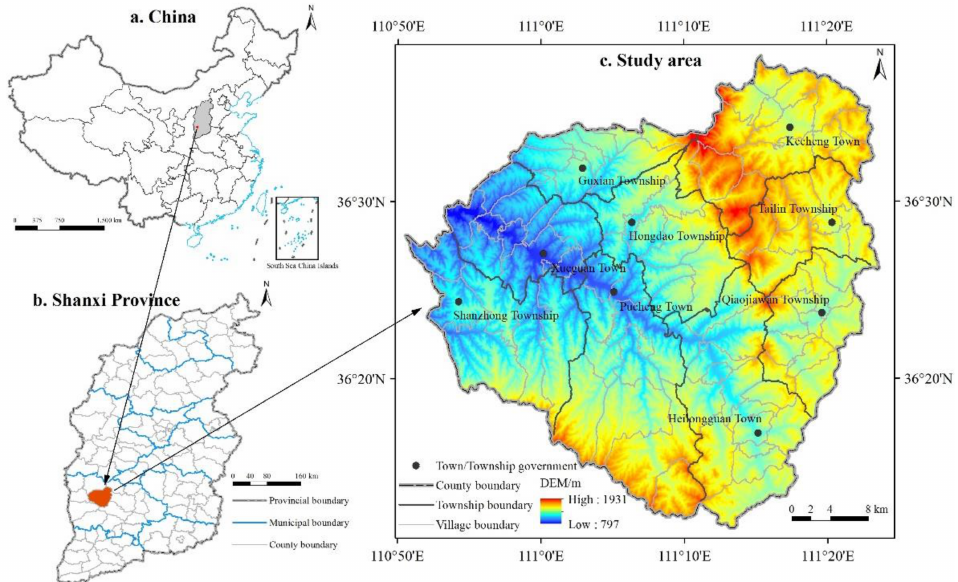
Figure 1. Location of Pu County ( a ), and of Shanxi Province ( b ) in China ( c